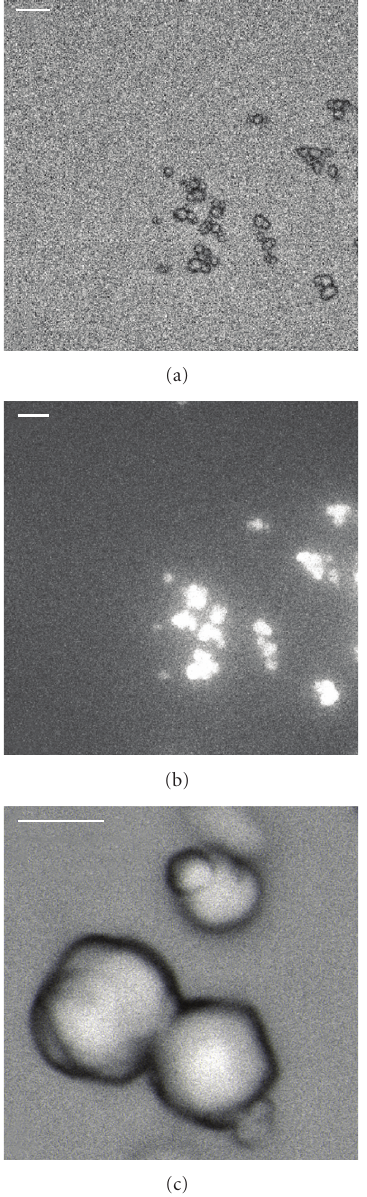
Figure 3: Microscope images of MCM-DPA sample, (a) and (b) reflected and emitted light, respectively, from silica particles on glass substrate and (c) software-assisted zoom, showing silica powder morphology (scale bars 10 μ m).